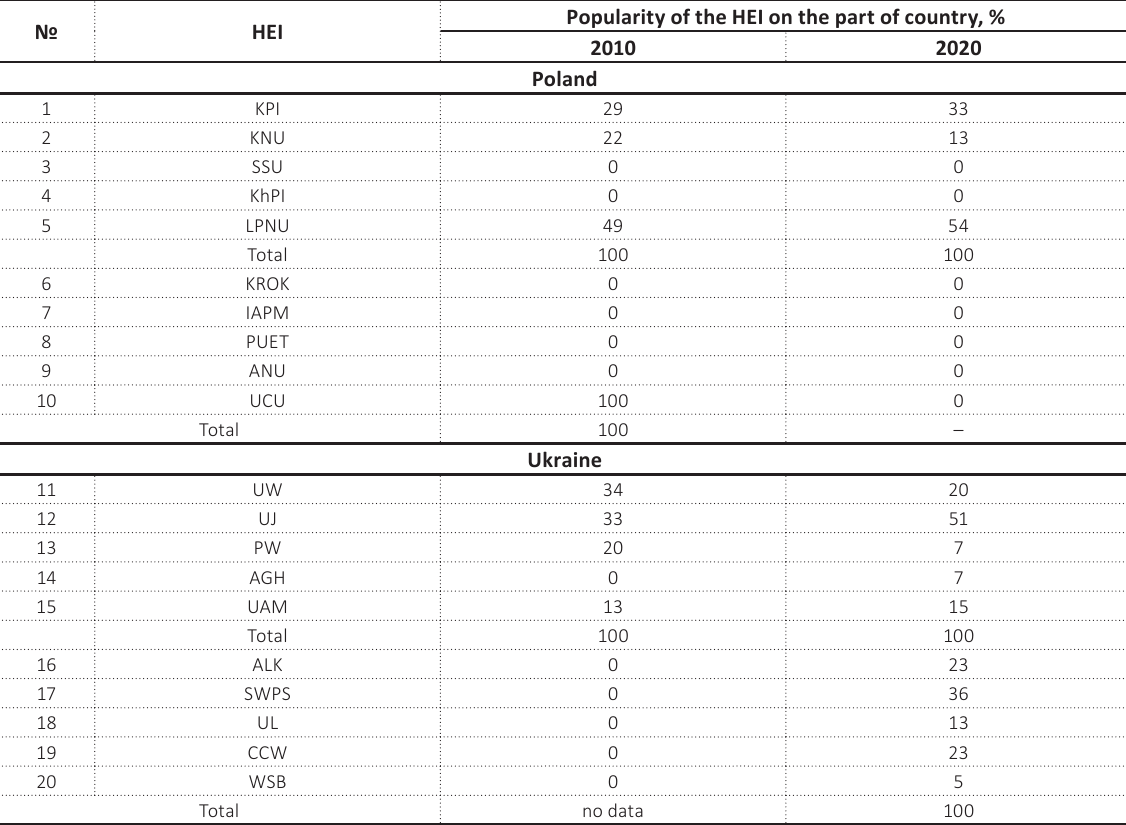
Table 6. Comparison of the popularity of the official term of HEIs in Ukraine and Poland in the Google search system in 2010 and